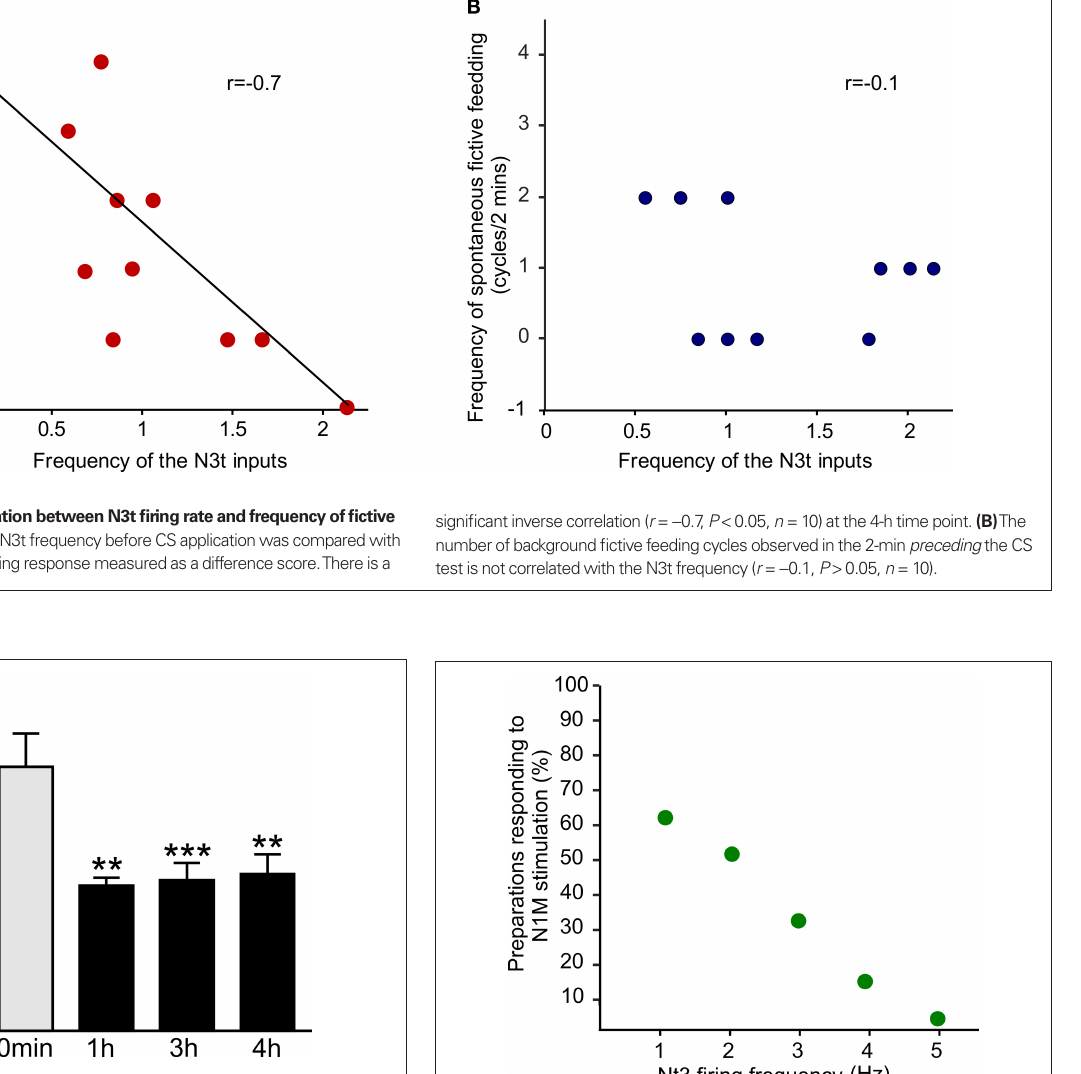
Figure 6 | Delayed decrease in fictive feeding cycle duration after conditioning. The duration of fictive feeding cycles at 1, 2, and 3 h after pairing were compared with the duration at 10 min after pairing. There is a statistically significant reduction at the 1, 2, and 3 h time points compared with 10 min (see text for statistics) but no other significant difference between the groups.